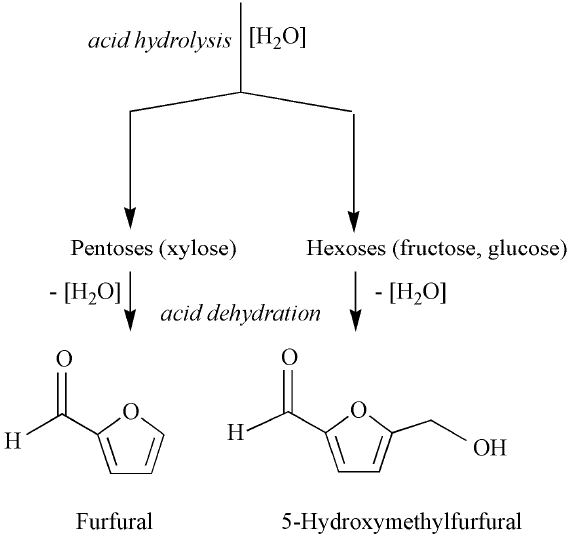
Figure 5. Simplified representation of the acid hydrolysis and dehydration of saccharides into FUR and HMF.